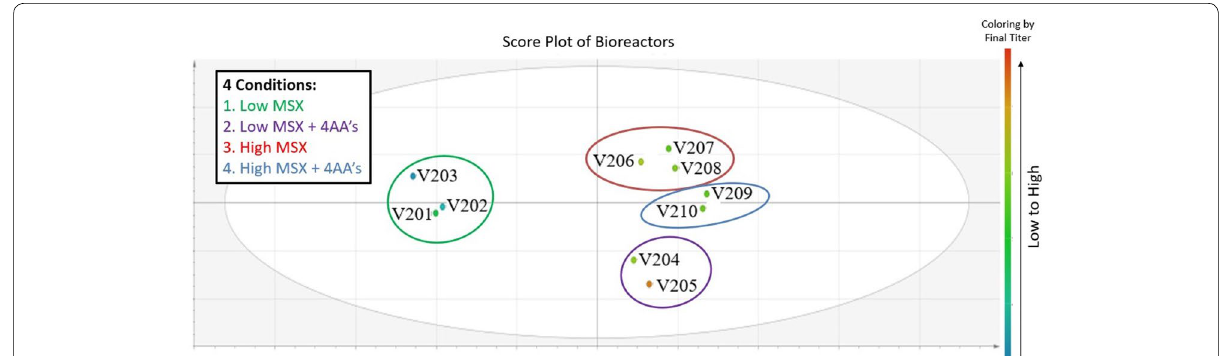
Fig. 2 Score plot: The score plot given in this figure is a direct result from the batch evolution model (BEM) that SIMCA analyzes. It shows that each of the reactors from each condition appears to group together on the score plot. This indicates high similarity between each bioreactor in a given condition which would be expected. Furthermore, from this score plot, it is apparent that with the addition of amino acids there is a distinct improvement in titer. This is apparent from the coloration of each data point (representing each reactor) where a bluish color indicates low titer and a reddish color indicates high titer. When comparing the first group of reactors (green circle with V201, V202, and V203) with the second group of reactors (purple circle with V204 and V205), it is possible to see that the titer of the first group is lower than that of the second group which indicates that the addition of 4 amino acids to the bioreactor cultivation had a positive impact on titer